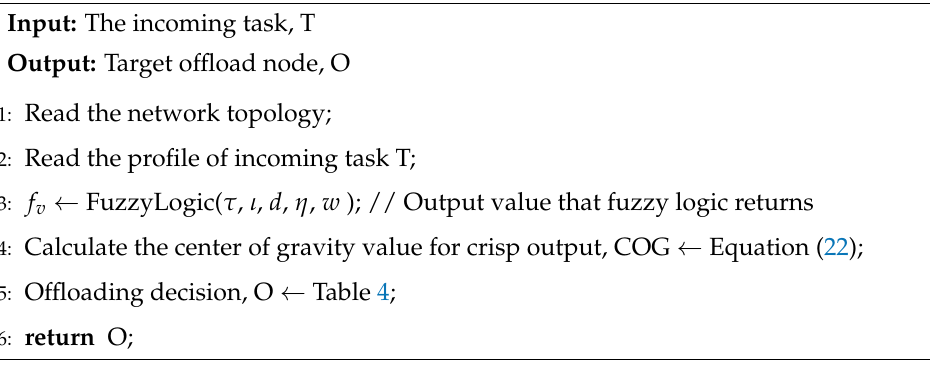
Figure 10. Defuzzification process: ( a ) output membership function; ( b ) the centroid defuzzifica- tion process. Algorithm 1 Fuzzy Decision-Based Task Offloading Management (FTOM)